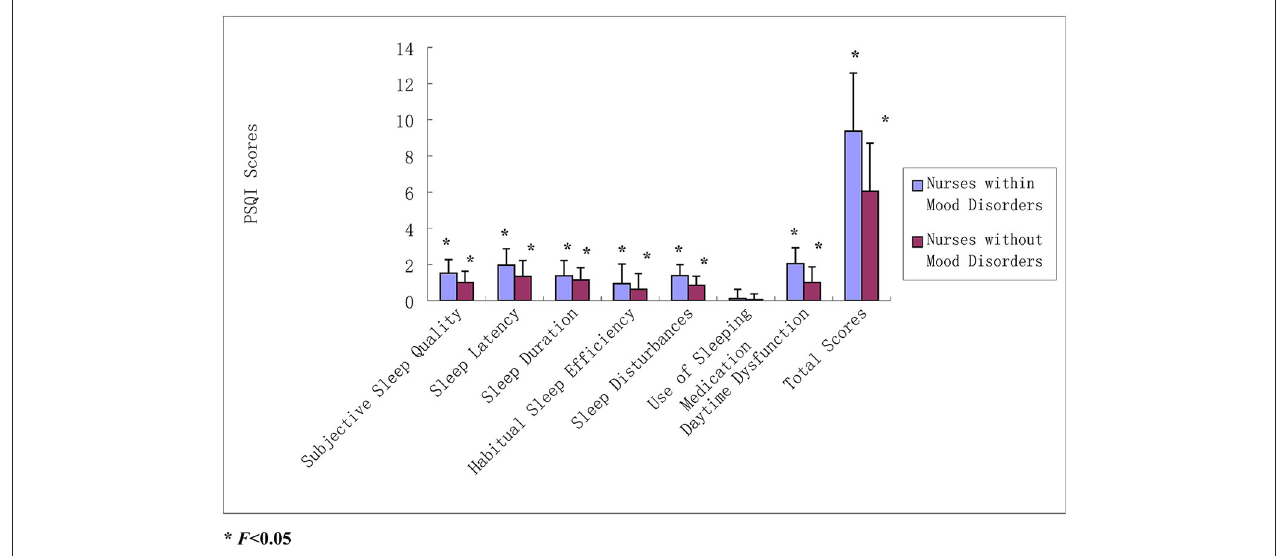
FIGURE 1 | PSQI scores between neonatal nurses and mood disorders. All part of total PSQI scores and total PSQI scores among neonatal nurses with mood disorders were all higher than those without mood disorders. The differences in subjective sleep quality, sleep latency, sleep duration, habitual sleep efficiency, sleep disturbances, daytime dysfunction, and total PSQI scores (all P < 0.05).